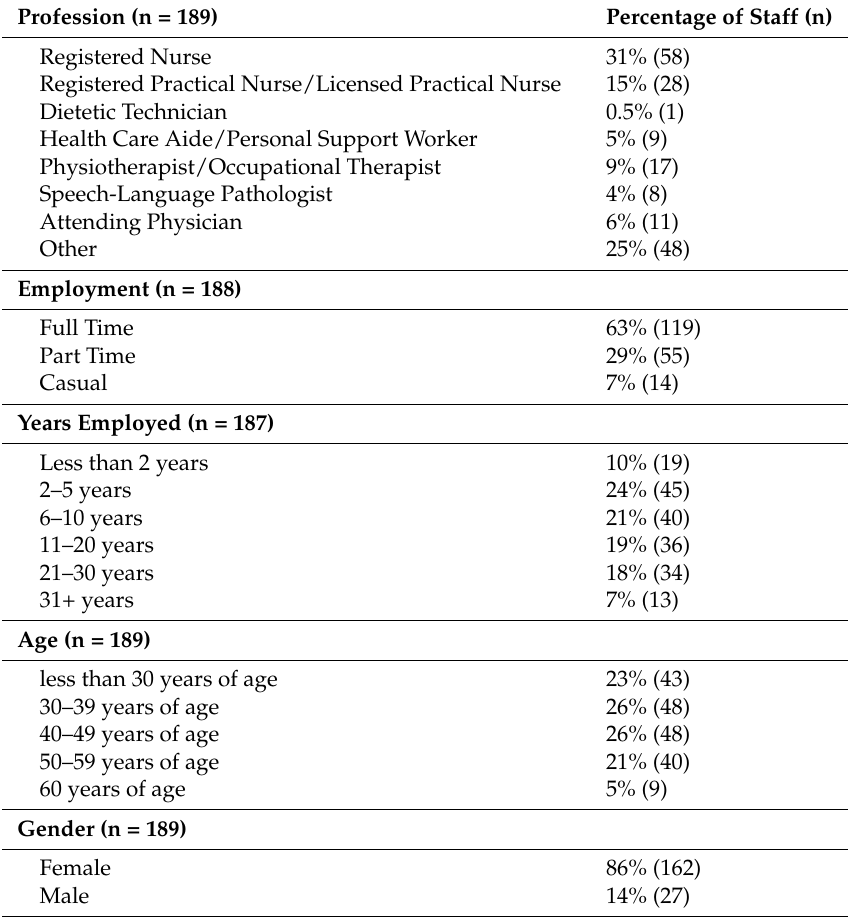
Table 3. Study 2: Demographic information of the hospital staff across five